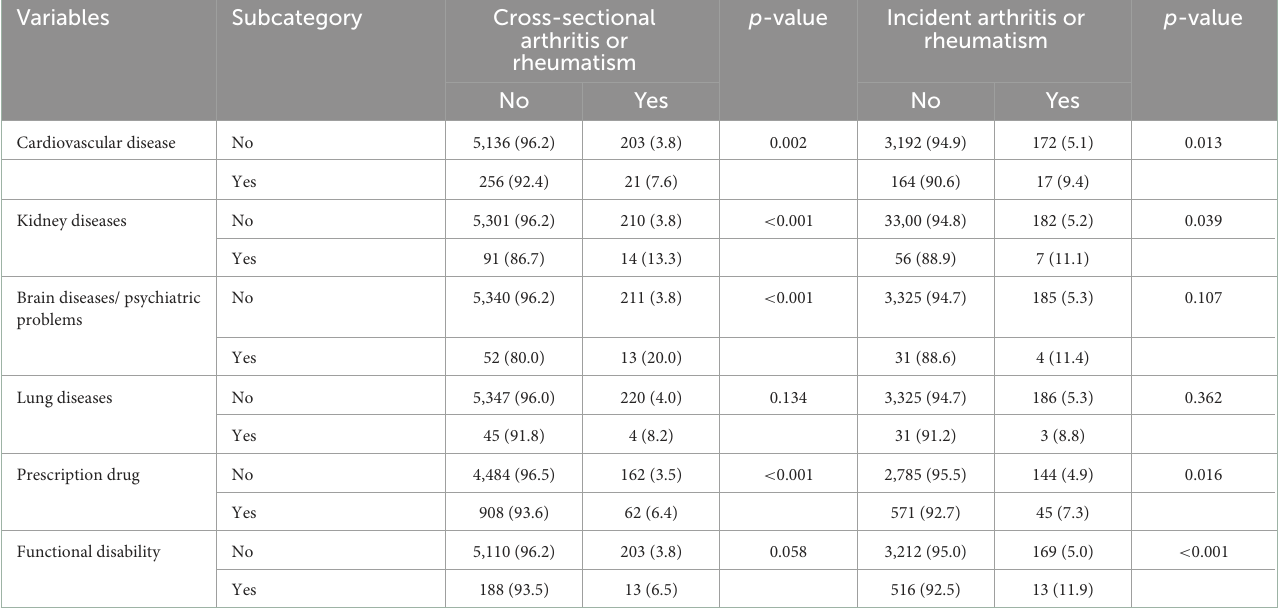
Cross-sectional associations with SRA In the multivariable model, brain disease and/or psychiatric